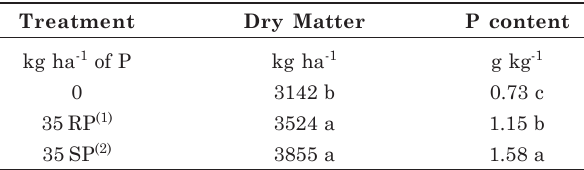
(1) RP: Reactive Phosphate; (2) SP: Superphosphate. Different letters in the columns show significant differences (LSD,